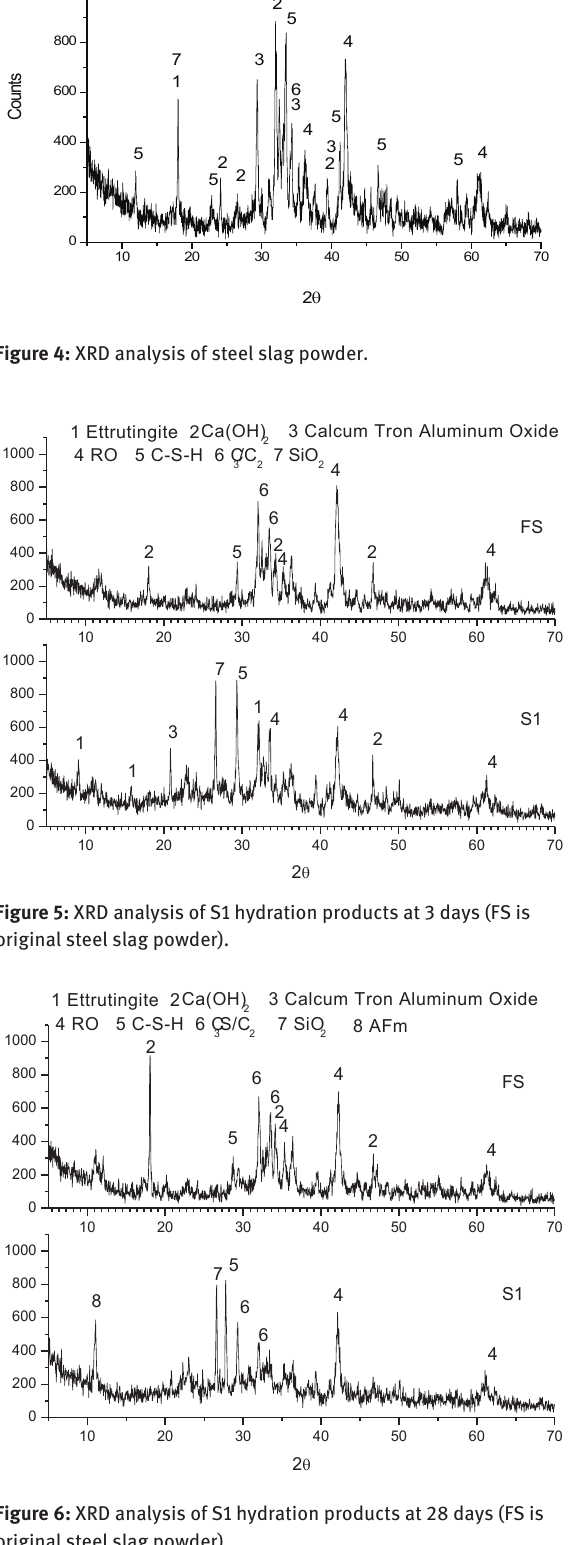
Figure 6: XRD analysis of S1 hydration products at 28 days (FS is original steel slag powder).